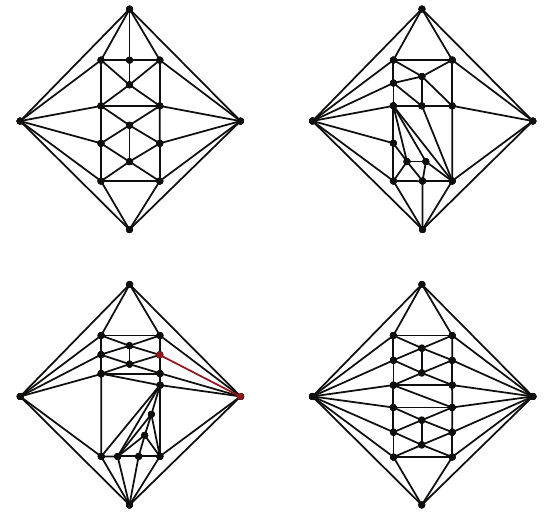
Figure 4. Each of the four graphs becomes a Kempe-locked triangulation when the leftmost and rightmost vertices on the exterior 4-face are joined. Three of the near-triangulations have a single Birkhoff diamond subgraph; the other near-triangulation has